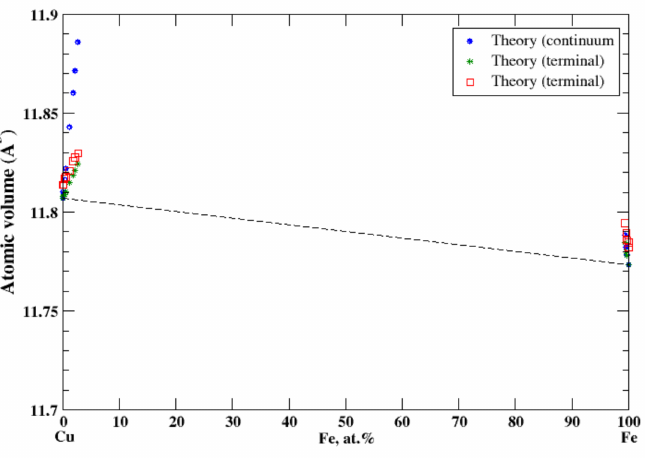
Figure 9. Atomic volume vs. concentration for Cu-Fe alloy system. The experimental data are from Ref. [16] (p. 571 and p.